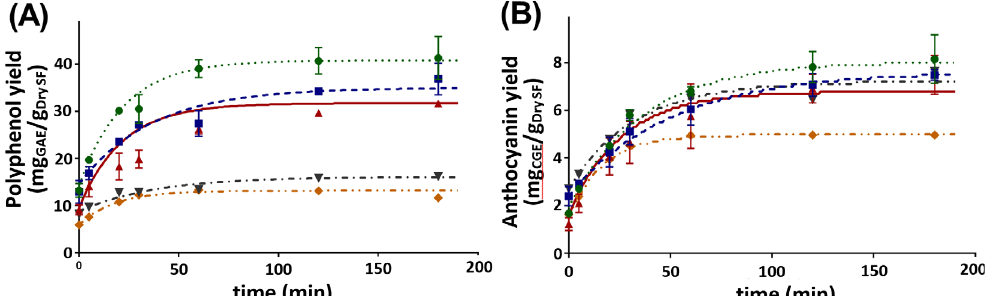
Figure 1. Solid–liquid ratio influence on conventional solid–liquid extraction for ( A ) polyphenol and ( B ) anthocyanin extraction. ● S:L = 0.10 g/mL, ■ S:L = 0.20 g/mL, ▲ S:L = 0.30 g/mL, ▼ S:L = 0.50 g/mL, ♦ S:L = 0.75 g/mL.